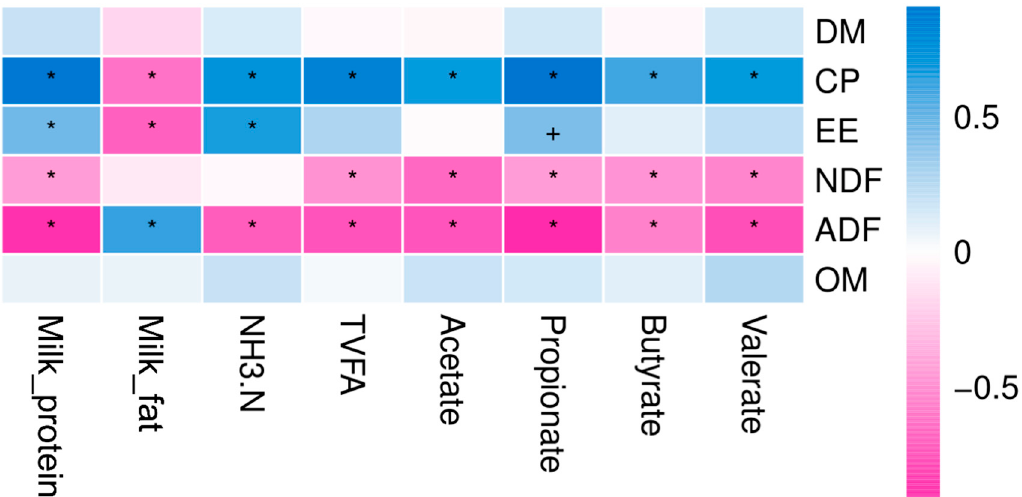
Figure 4. Spearman correlation and clustering analysis between milk composition, ruminal fermentation parameters, and nutrient composition of herbage. The depth of the color indicates the correlation between species and environmental factors. DM: dry matter, CP: crude protein, EE: ether extract, OM: organic matter, NDF: neutral detergent fiber, ADF: acid detergent fiber, TVFA: Total volatile fatty acids, NH3-N: ammonia nitrogen. The “+” and “*” indicates the different level at 0.05 and 0.01, respectively.